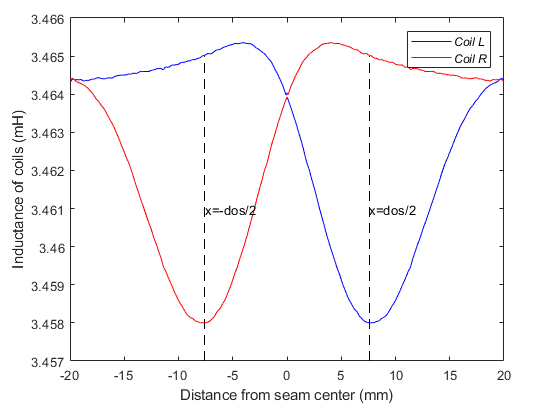
Figure 9. The inductance of separated coils of sensor with a different position of the weld ( d os = 15 mm).